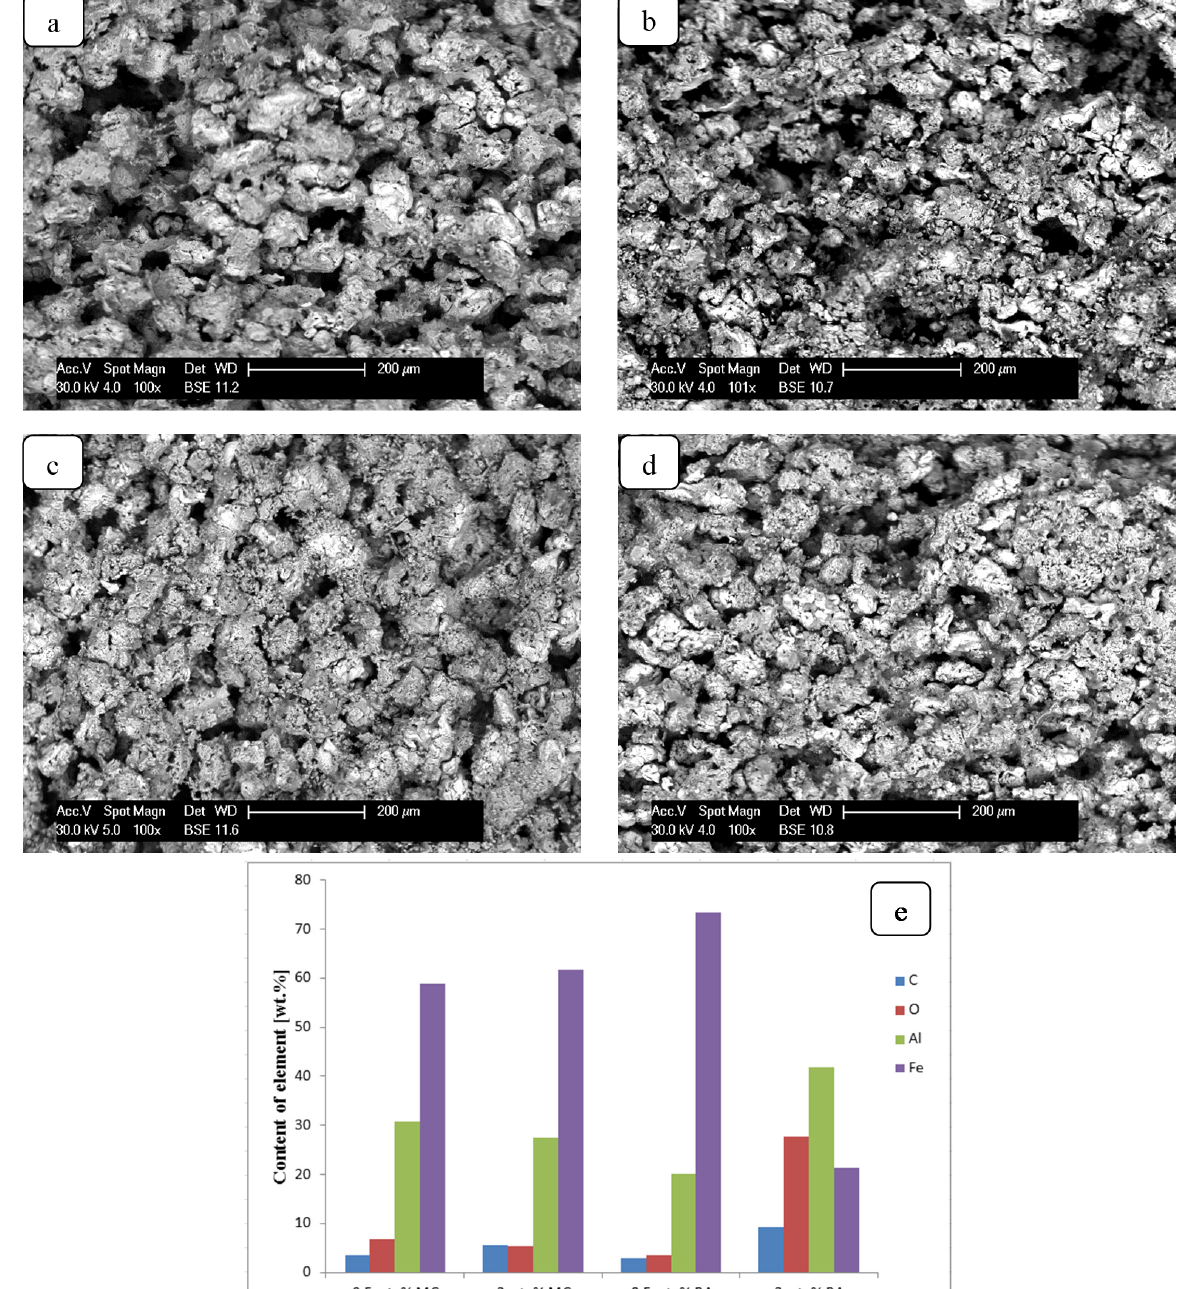
Figure 6. Microstructure of samples doped 0.5 wt% MC ( a ); 3 wt% MC ( b ); 0.5 wt% PA ( c ); 3 wt% PA ( d ); and EDS composition of obtained sinters ( e